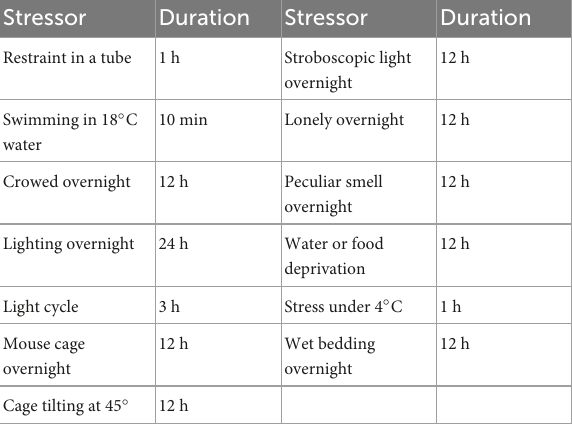
(SPT), open field test (OFT) elevated plus-maze (EPM), and force swimming test (FST), were carried out in turn. All the behavioral tests were performed with the observer blind, and the rats were sacrificed two days after the behavioral tests. Serum